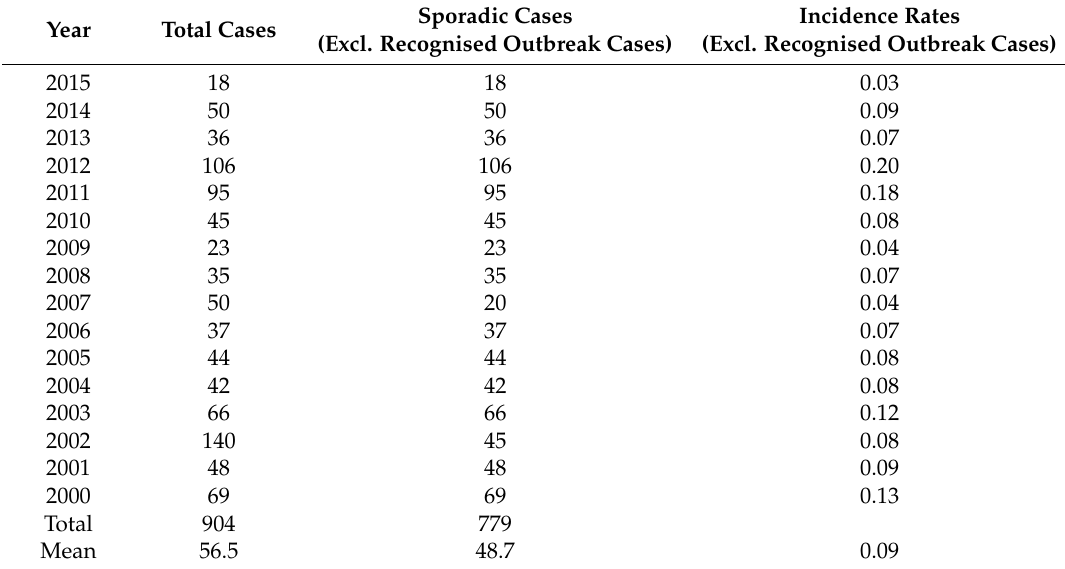
Table 1. Acute Q fever cases and incidence rates in England and Wales (2000–2015). Incidence rates per 100,000 population, using ONS mid-year populations estimates (as at 30 June 2006) [14].